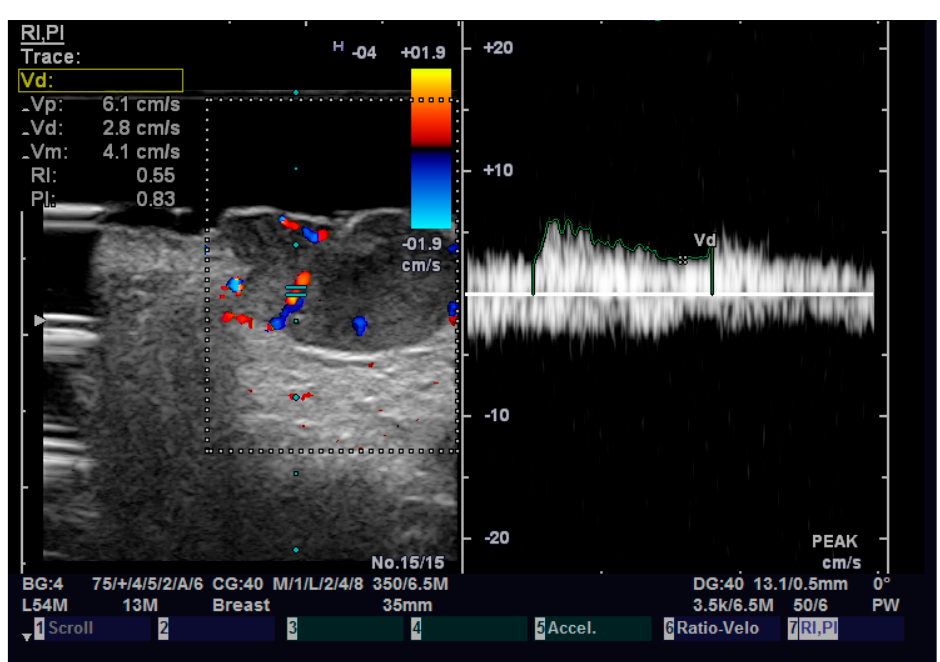
Figure 7. Doppler examination of a SCC. Table 4. Pulsatility index, resistive index, strain ratio, diastolic speed and systolic speed related to histopathological type.